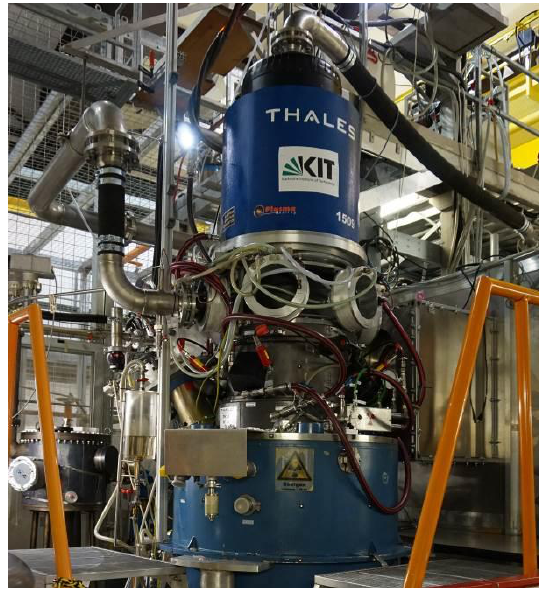
Fig. 6. The EU 1MW, 170 GHz CW industrial prototype gyrotron installed at the KIT superconducting magnet.